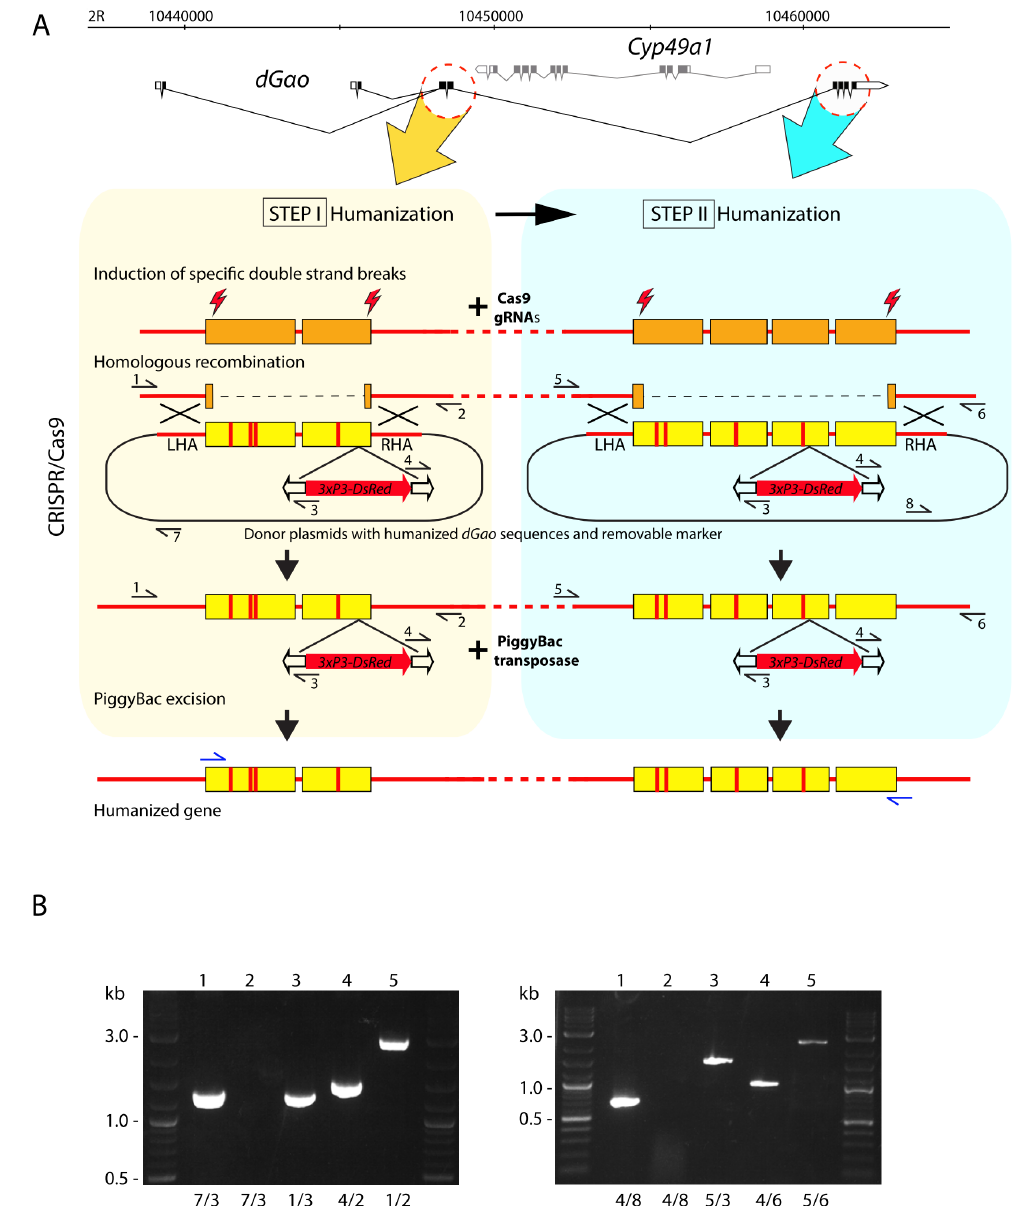
Figure 2. A . Two-step strategy for genomic humanization of dGαo. The primers for validation of the correct donor sequence integration in the genome are designated with black horizontal arrows and marked with digits. Primers used in RT-PCR are designated with blue horizontal arrows. LHA and RHA: left and right homologous arms in the donor plasmids required for homologous recombination with the genomic sequences. The exons with vertical red lines schematically designate humanized sequences with mismatches. B . Agarose gels with PCR products obtained with the primers as numbered below each lane (see Supplementary Table S1 for sequences). Lanes 1: control PCR from donor plasmids pLdhGαo23R (left panel) and pLdhGαo47R (right panel). The absence of a PCR product (lanes 2) performed with the same primers from the genomic DNA of transgenic flies indicates the correct integration of the donor sequences without the plasmid backbone. Lanes 3 and 4: verification of the entire integration of the donor sequence in the genome before excision of the 3xP3-dsRed marker. Lanes 5: PCR through the integrated donor sequence after the excision of the 3xP3-dsRed marker from genomic DNA of the homozygous stocks Gαo[h23ex4aa-1] (left panel) and Gαo[humanized-1] (right panel).